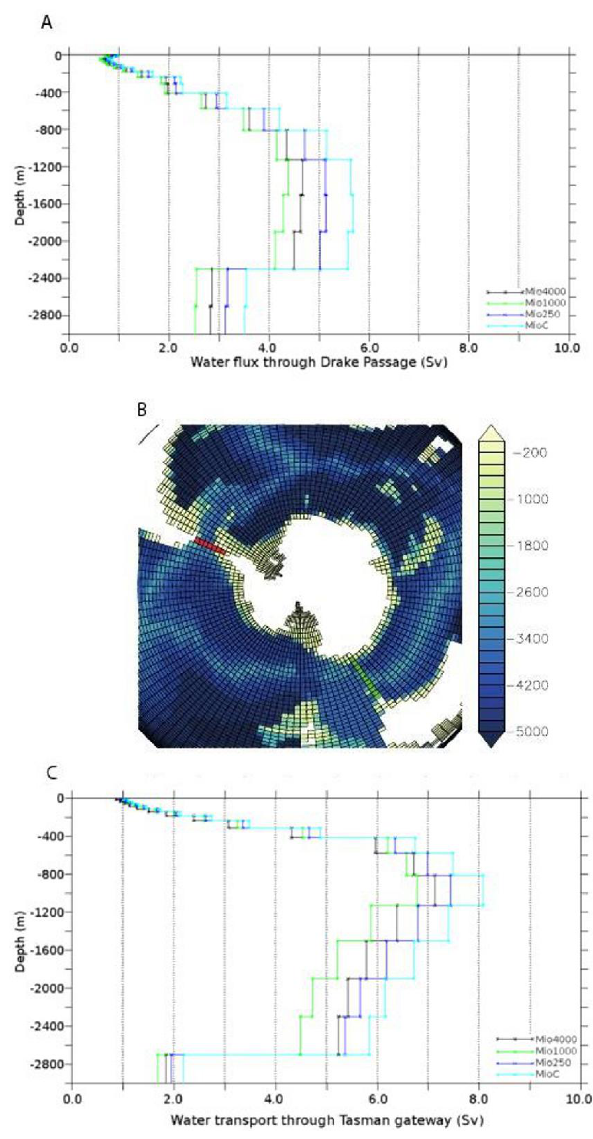
Fig. 11. (A, C) Zonal water transport through Drake (A) and Tasman (C) gateways, for the four experiments. (B) Focus on bathymetry used in all experiments. Coloured segments indicate grid points where water transports have been